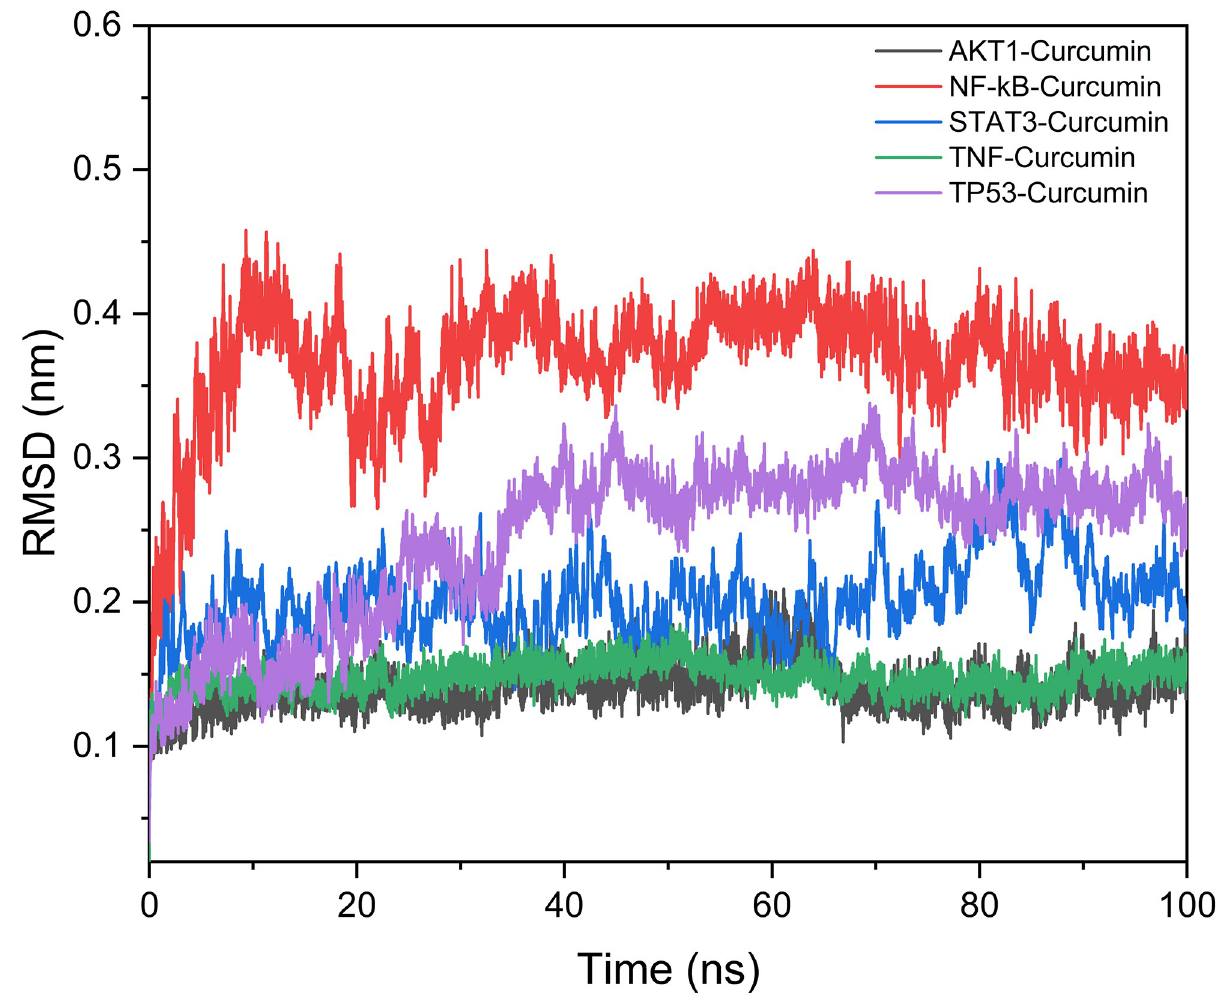
Fig 7. RMSD of the protein − ligand complexs during